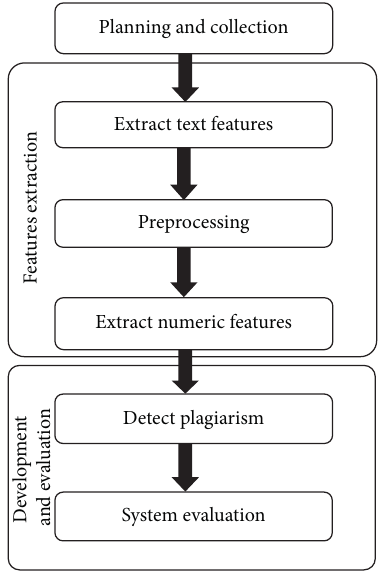
Figure 4: Flowchart of